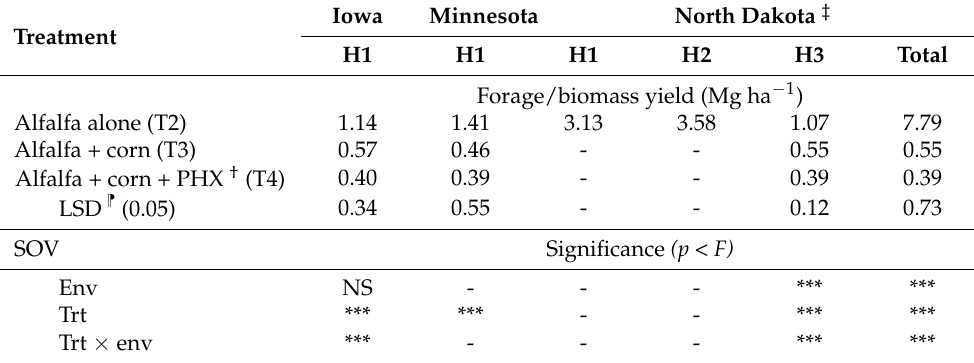
Table 7. Alfalfa forage yield in the first production year for four harvests (H1, H2, H3, and H4), and total seasonal averaged across environments (Env) within a same state † and significance of effects (source of variation, SOV) in the model. Treatment